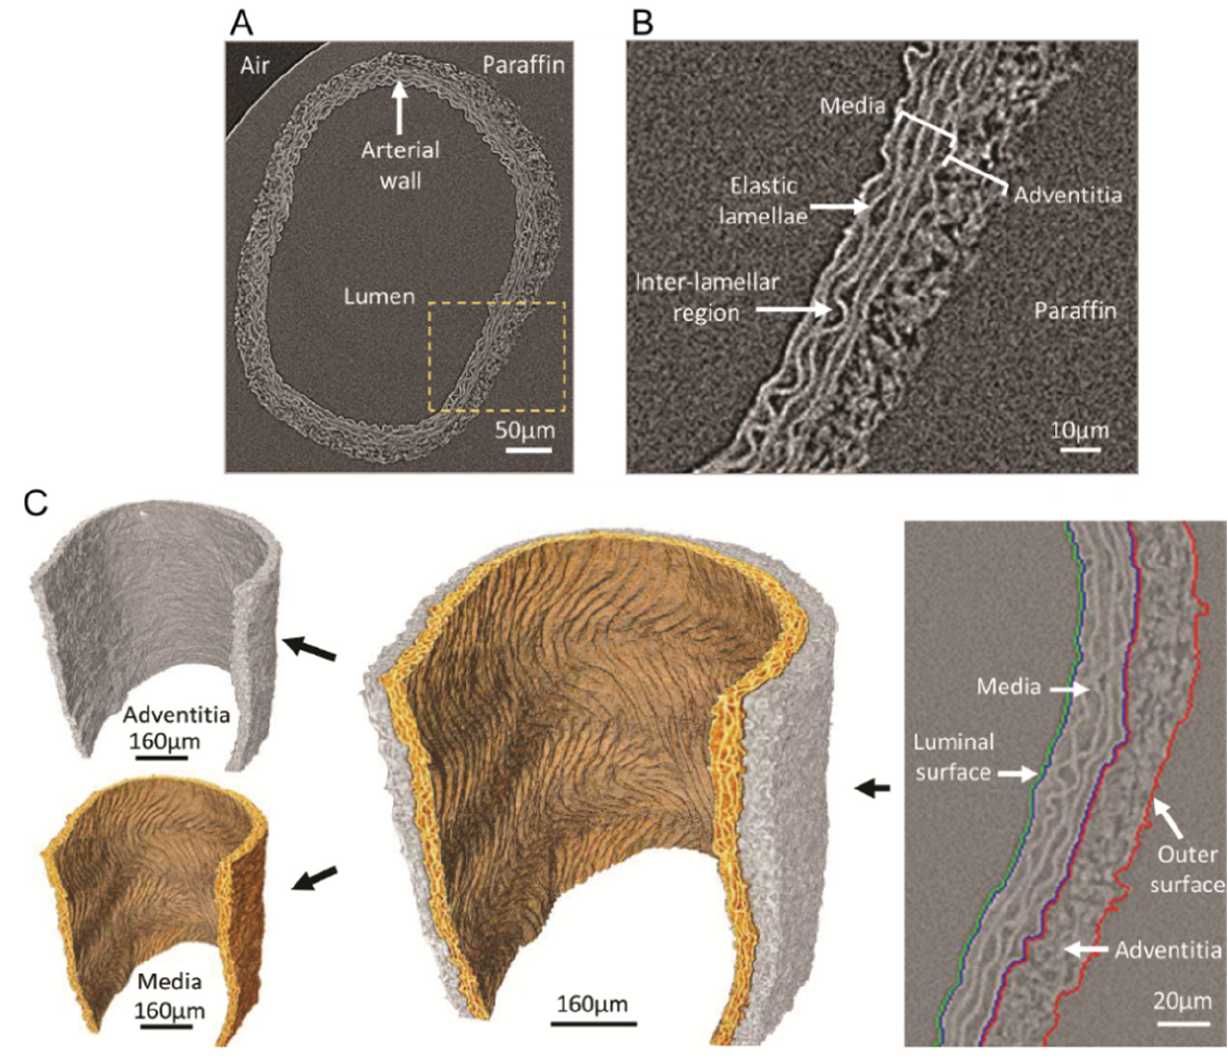
Figure 8. Paraffin-embedded rat common carotid artery without CESA. Major arterial substructures are readily identifiable in the vessel wall. ( A ) Virtual slice extracted from an X-ray tomogram of an intact rat common carotid artery (yellow box indicates the magnified region in panel ( B ). ( B ) Major arterial substructures. ( C ) Rendering showing the output of the segmentation process that enables the medial and adventitial layers to be virtually dissected (adapted from and with kind permission from Reference [113]—licensed under the Creative Commons Attribution 4.0 International License [95]).